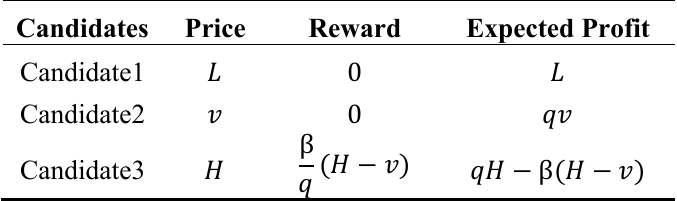
Table 1. Candidate strategies when (cid:1838) (cid:3409) (cid:1874) (cid:3407) (cid:1834)